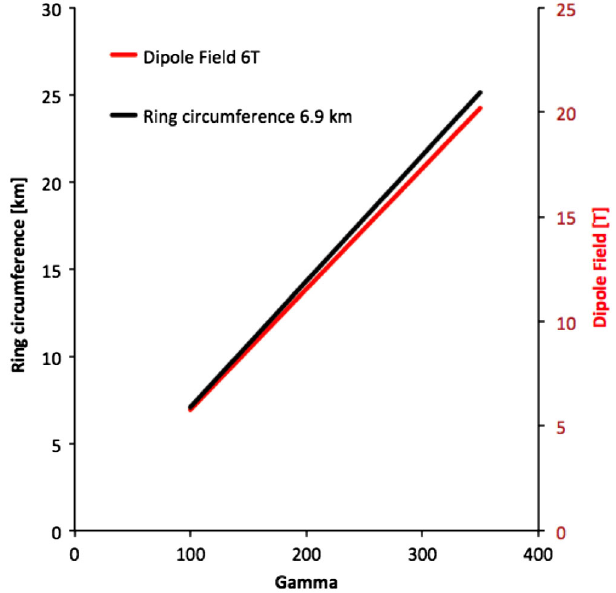
FIG. 41. Dependence of the gamma factor on ring circum- ference (constant field, 6 T) and of the field (constant ring circumference, 6.9